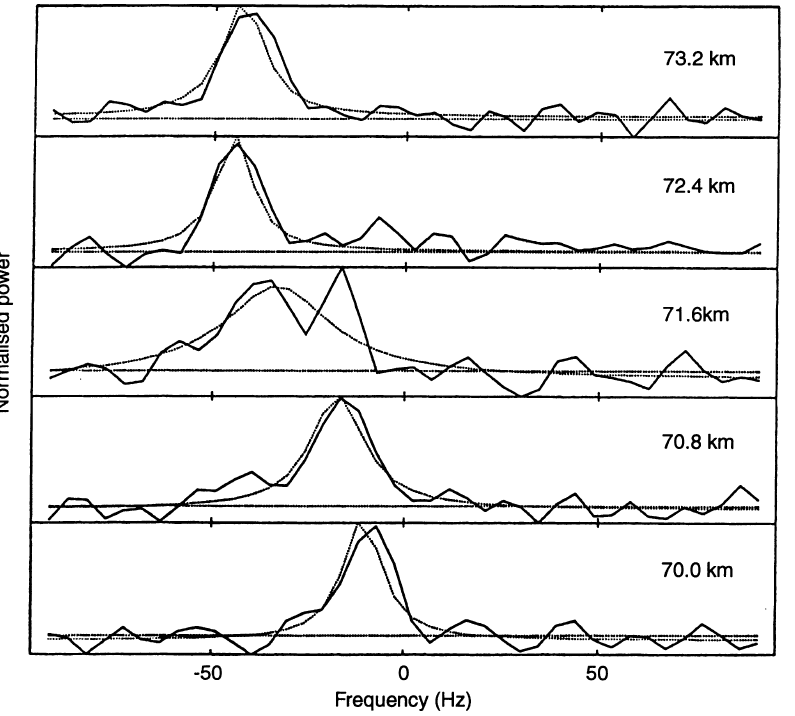
Fig. 4. Measured ( full lines ) and fitted ( dotted lines) VHF spectra for five gates centred on 71.6 km altitude for the same time-interval as the results in